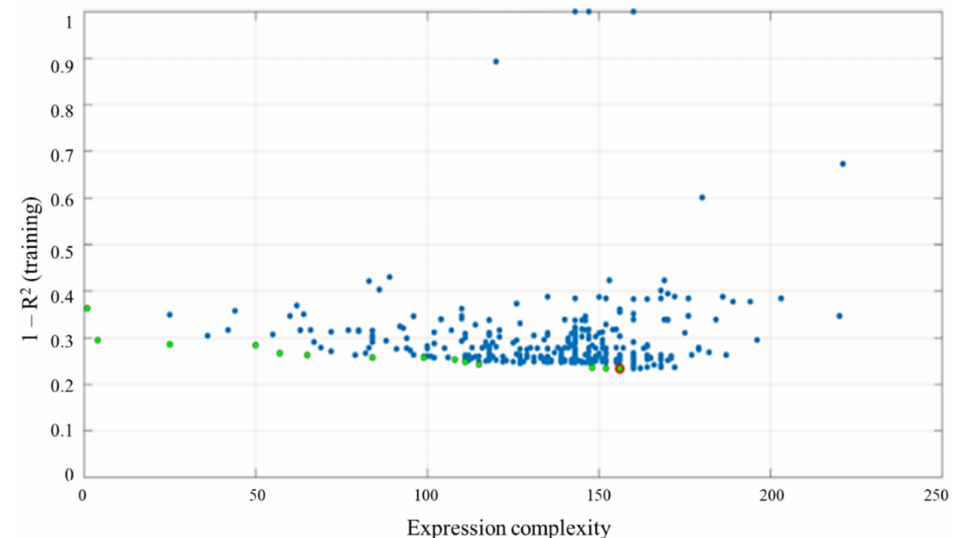
Figure 8. Pareto chart for MGGP